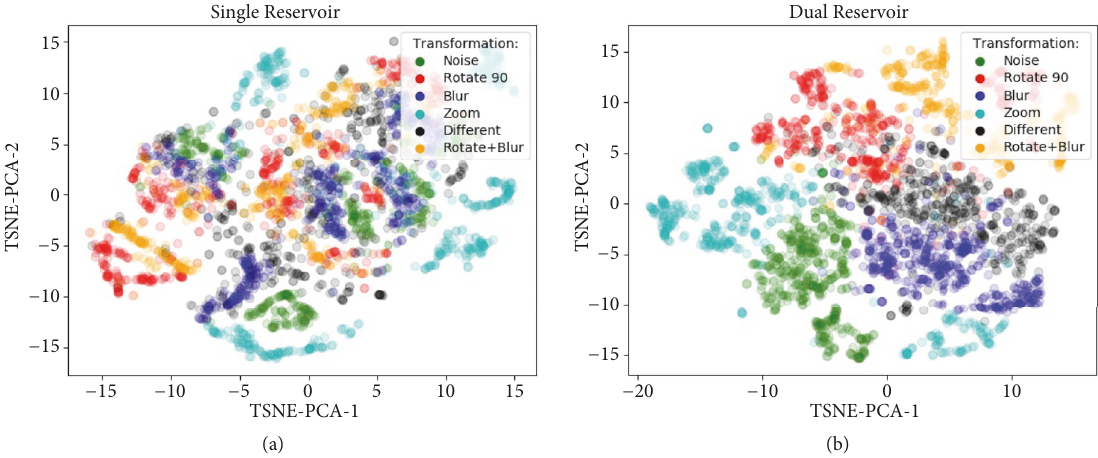
obtained using t-SNE on the 100 largest principal components of the reservoir system state trajectory for (a) single reservoir and (b) dual reservoir. Input images: digits 0-9 of MNIST dataset. 𝑁 𝑅 : 1000. t-SNE iterations: 300. perplexity: 40.